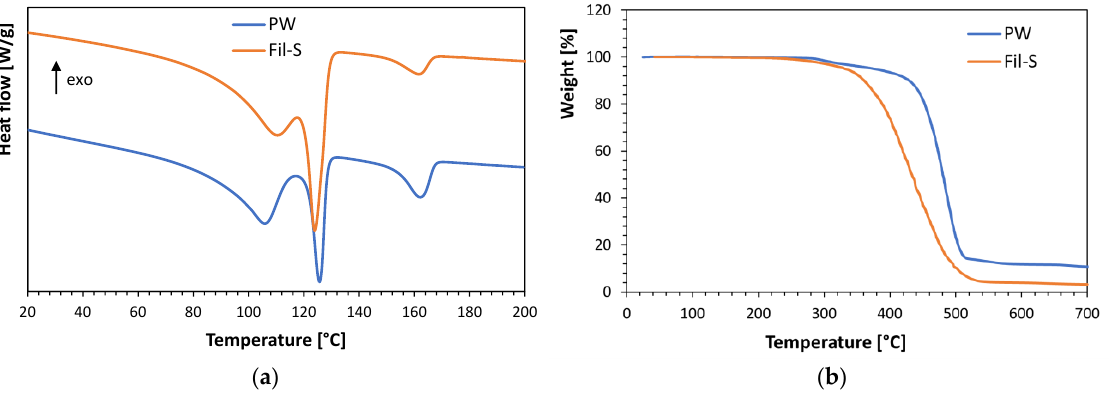
Figure 2. Comparison of the thermal data for PW and Fil-S: ( a ) 2nd heating DSC thermograms; and ( b ) thermogravimetric plots.